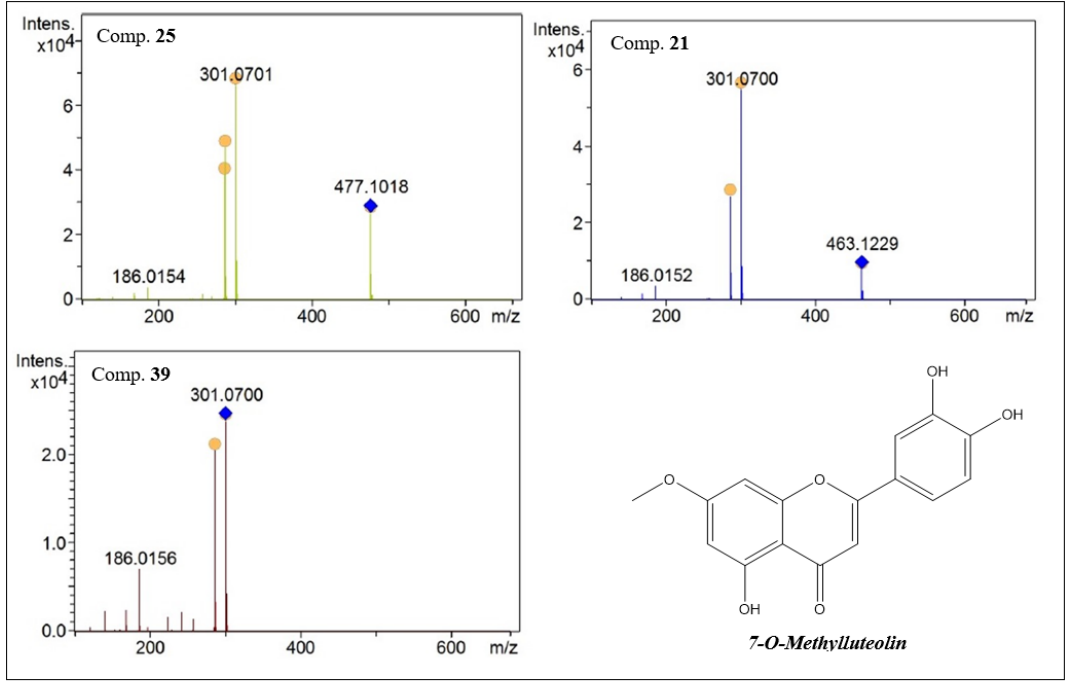
Figure 9. MS 2 spectra of flavones with 7- O -methylluteolin-like aglycones present in the ethanolic extract of F. chica leaves.